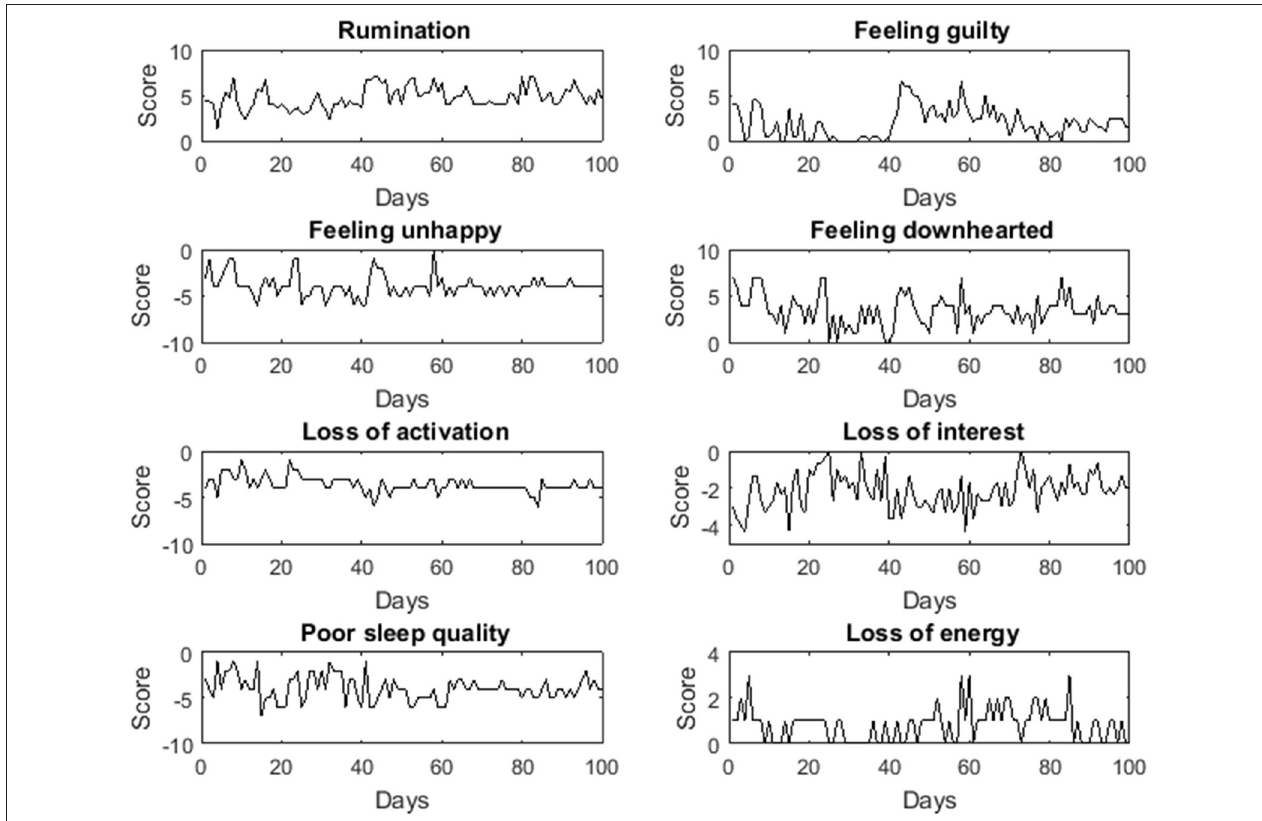
FIGURE 6 | Time series plots of the depression-related symptoms on 100 measurement occasions for one of the study participants.